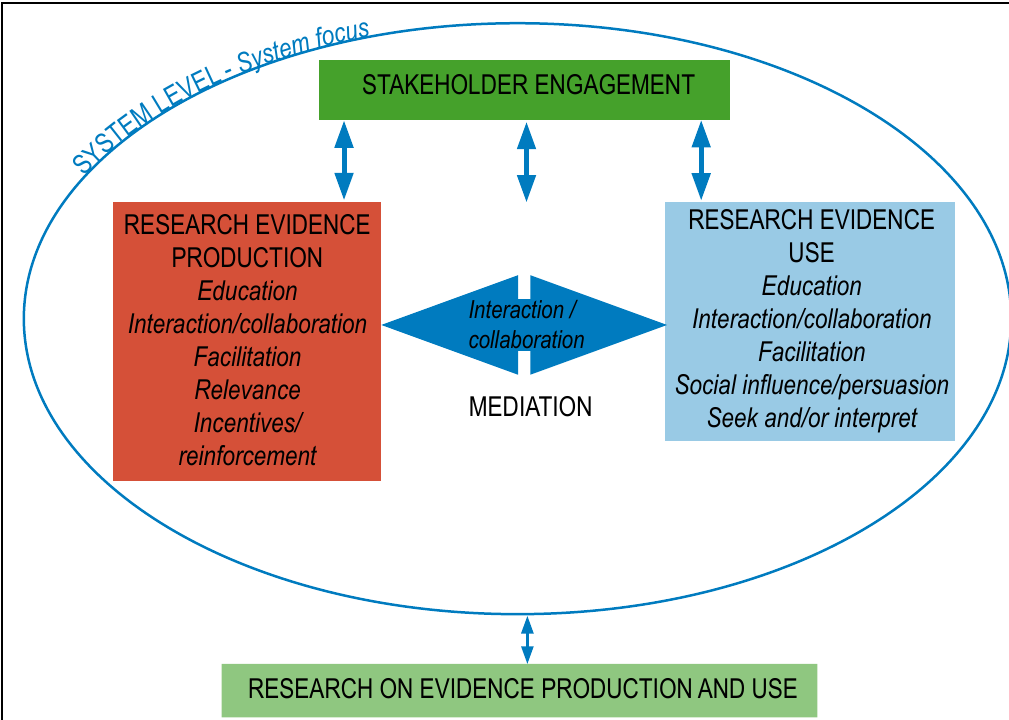
Figure 15: Actual location of the mechanisms within the research evidence production-to-use